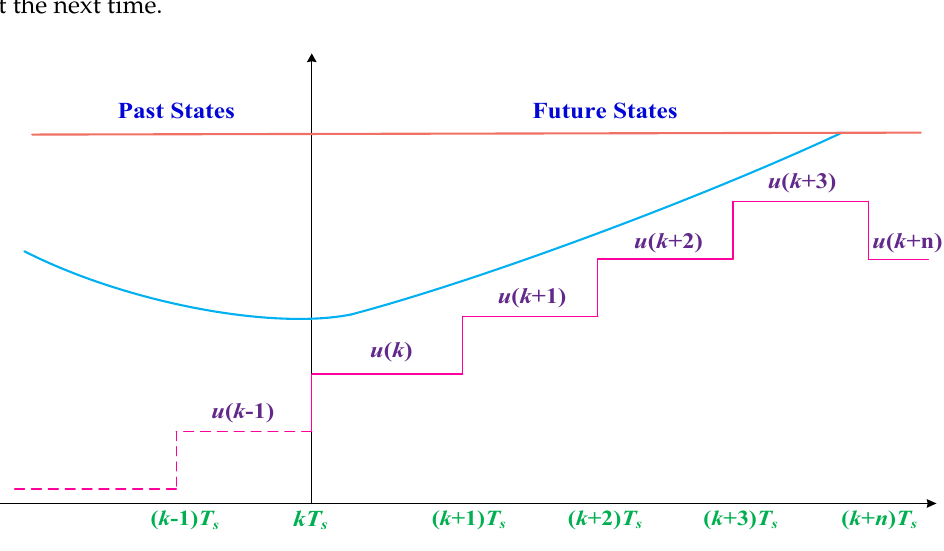
Figure 4. The working principle of model predictive control.